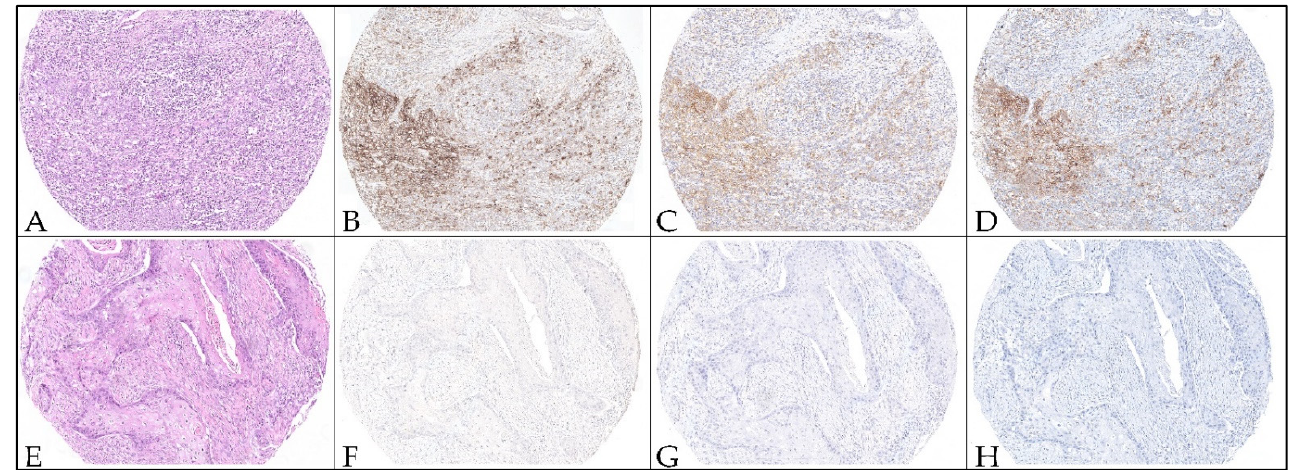
Figure 1. Representative micrographs of PD-L1 immunohistochemistry staining with different assays on TMA cores from head and neck squamous cell carcinoma. Hematoxylin and eosin-stained cores ( A , E ) with positive and negative PD-L1 expression. TMA cores from a case showing high CPS score values (CPS > 1) using the 22C3 pharmDx assay on Autostainer Link48 platform ( B ), 22C3 assay on Omnis platform ( C ), and SP263 assay ( D ). TMA cores from a case showing negative CPS score value (CPS < 1) using the 22C3 pharmDx assay on Autostainer Link48 platform ( F ), 22C3 assay on Omnis platform ( G ), and SP263 assay ( H ). Original magnification 100×.